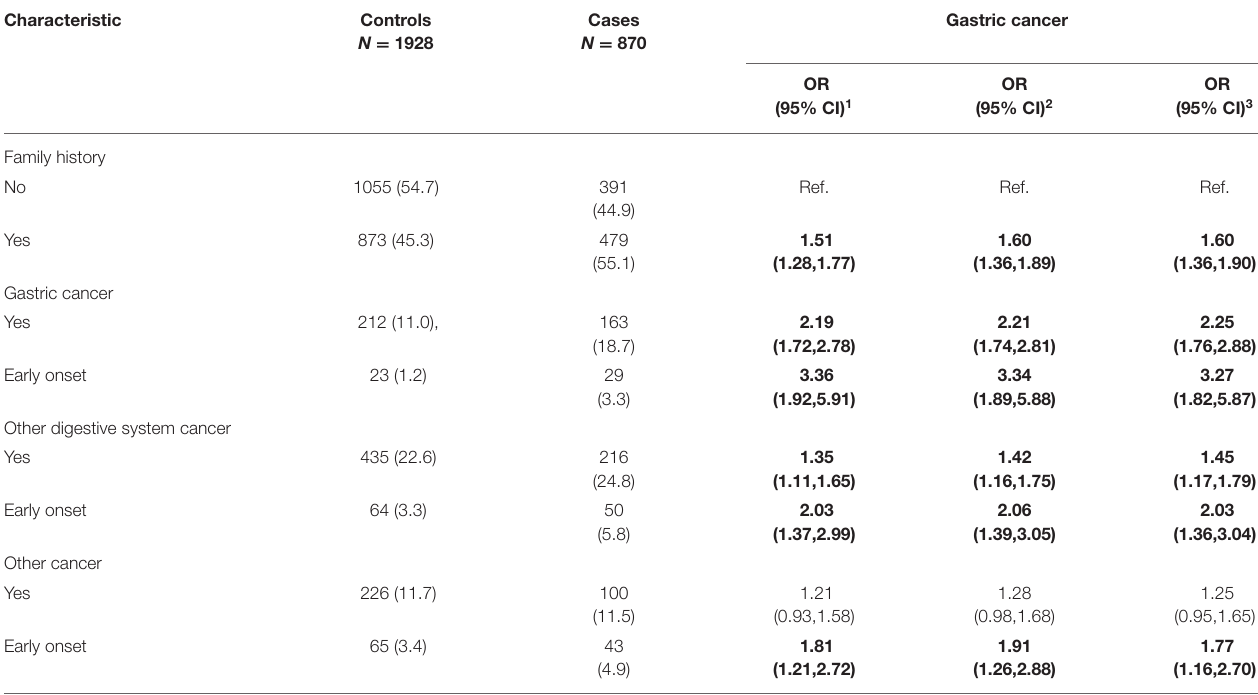
TABLE 4 | The association between family history of malignancy and risk of gastric cancer. Characteristic Controls